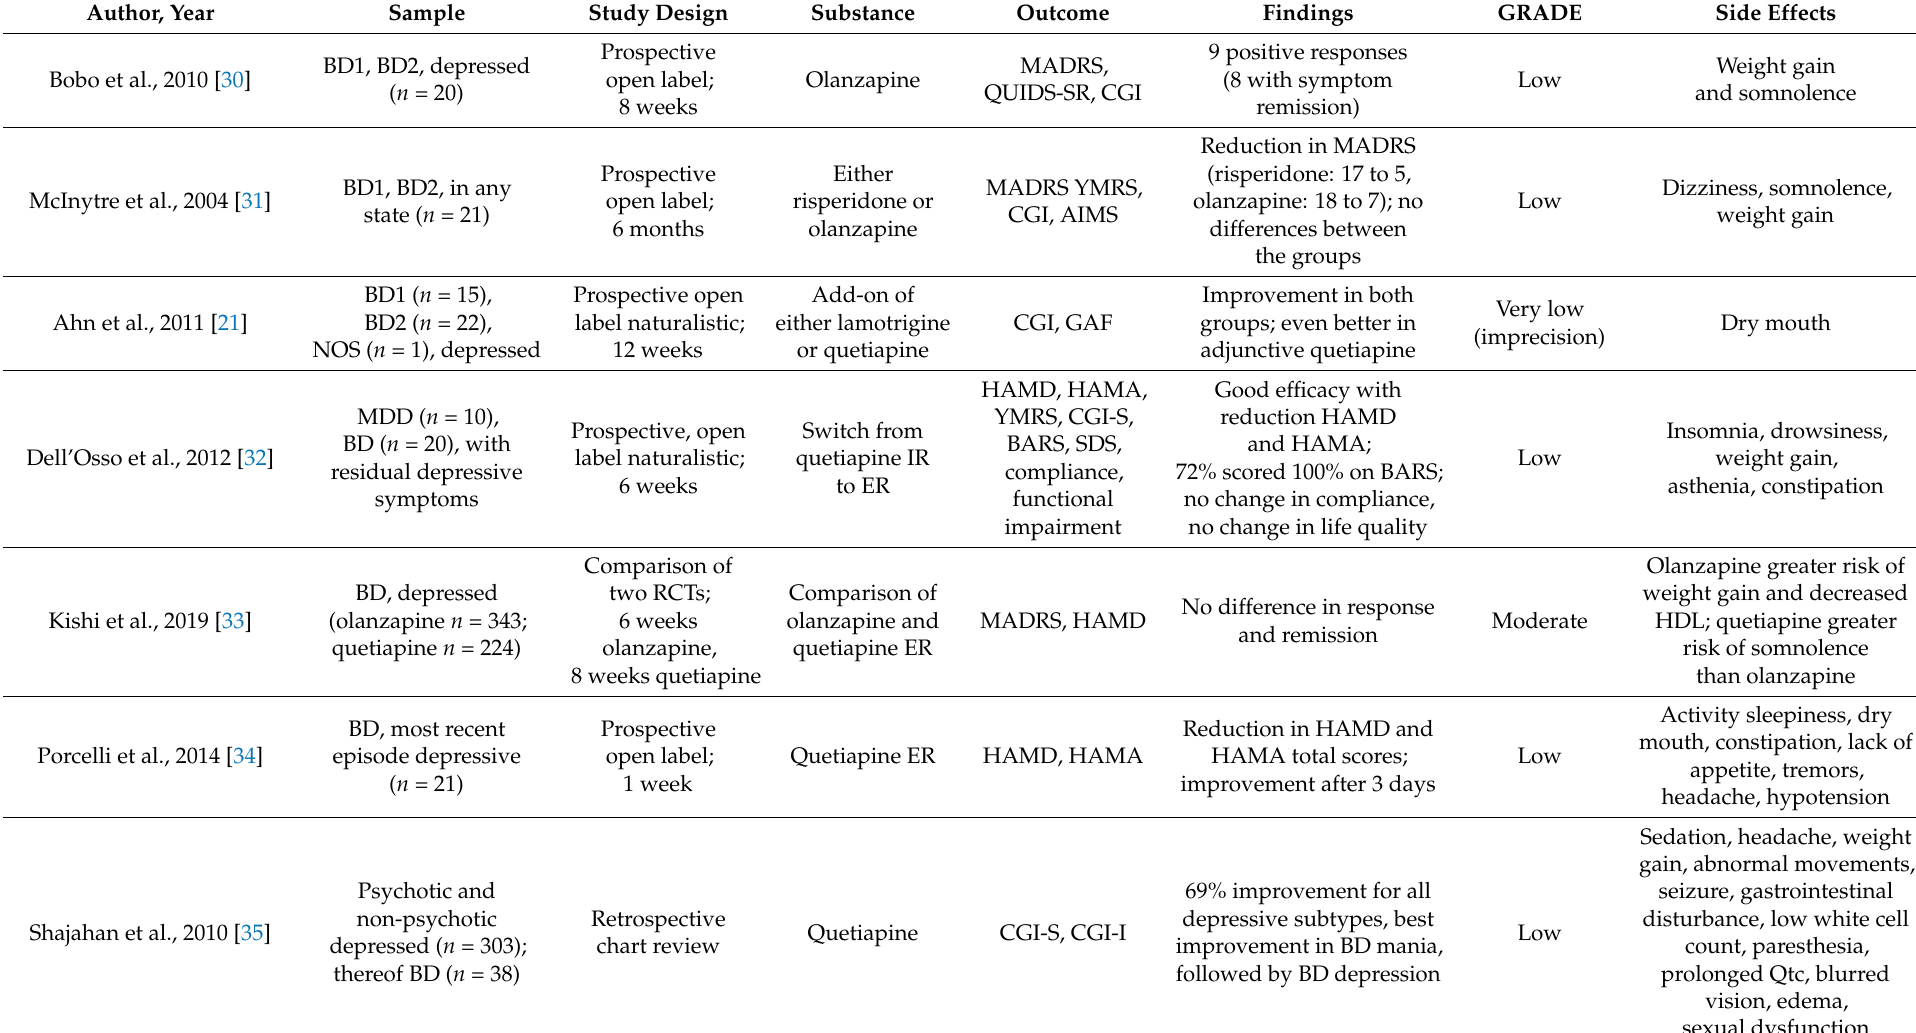
Table 2. Observational studies on antipsychotics in the treatment of bipolar